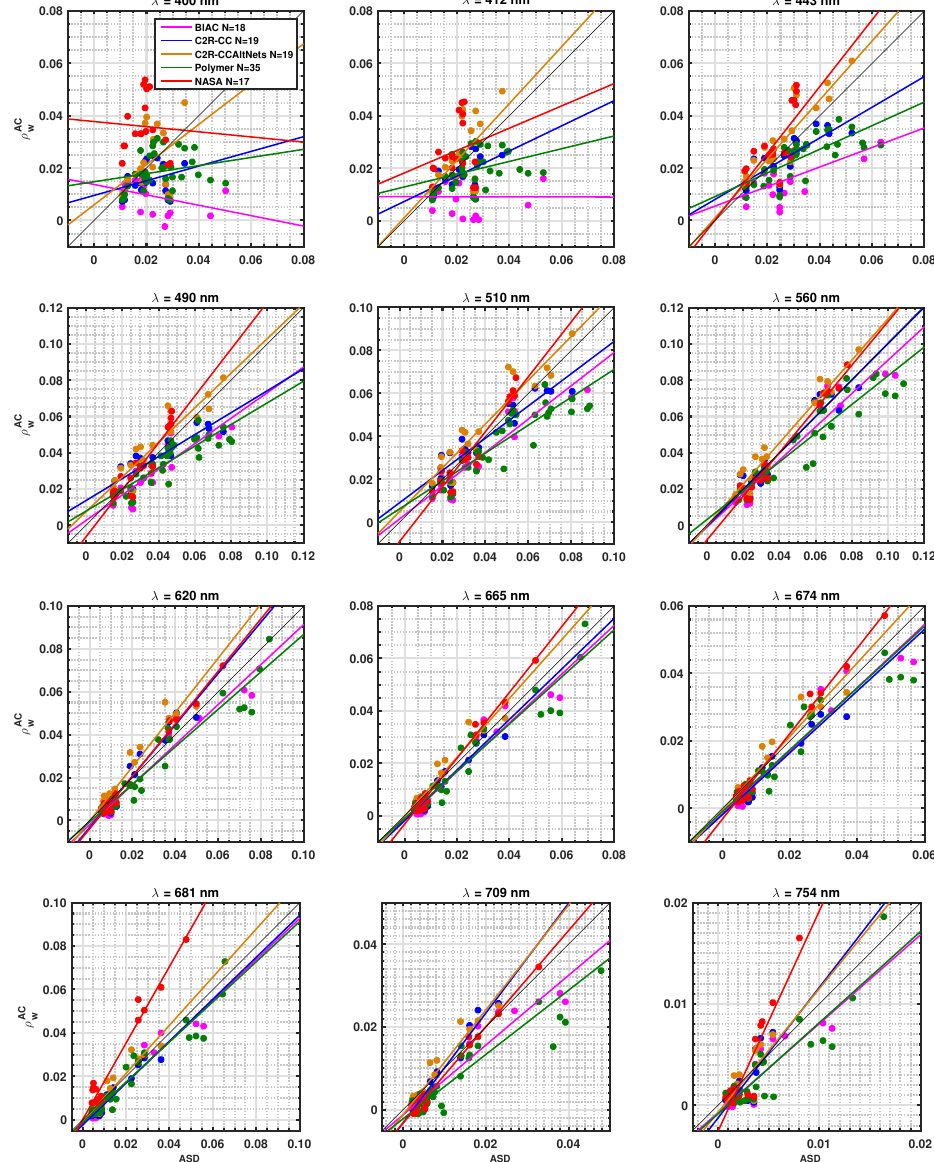
Figure 3. Scatterplots of the match-up exercise of the atmospheric correction algorithm (AC) retrieval and the field measured water-leaving reflectance for 400, 412, 443, 490, 510, 560, 620, 665, 674, 681, 709, and 754 nm. In the multiple scatterplots figure, the field measured OCR ( ρ ASD w ) ) are represented in the x-axis and the water-leaving reflectance AC retrieval ( ρ AC w ) ) is represented in the y-axis. The black solid lines represent the 1:1 line. The colored solid lines show the linear regression lines between the field-measured and AC retrievals of ρ w . The color lines code and the number of match-ups are indicated in the text box of the top left scatterplot ( λ = 400 nm), where magenta, blue, orange, green, and red colors stand for the baseline atmospheric correction algorithm (BlAC), the Case 2 regional coast color atmospheric correction algorithm (C2R-CC), the alternative neural nets of C2R-CC atmospheric correction algorithm (C2R-CCAltNets), Polymer, and NASA,